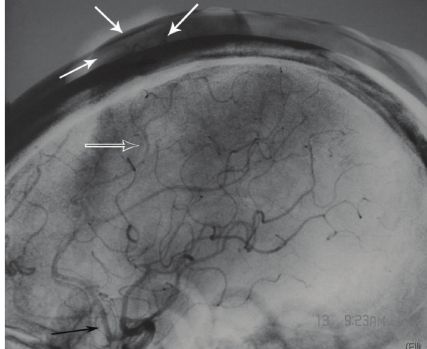
Figure 4: Digital subtraction angiography of left ICA (lateral projection). The black arrow shows the ACA, the hollow arrow shows a branch of the pericallosal artery, and the white arrows show thesupplytothetraumaticfistula.ICA:internalcarotidartery;ACA: anterior cerebral